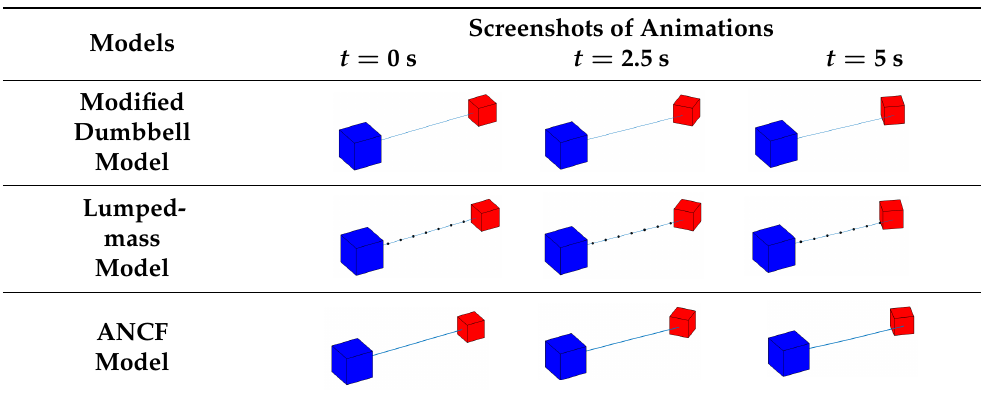
Table 2. Simulation Animation Screenshots for Single Tether